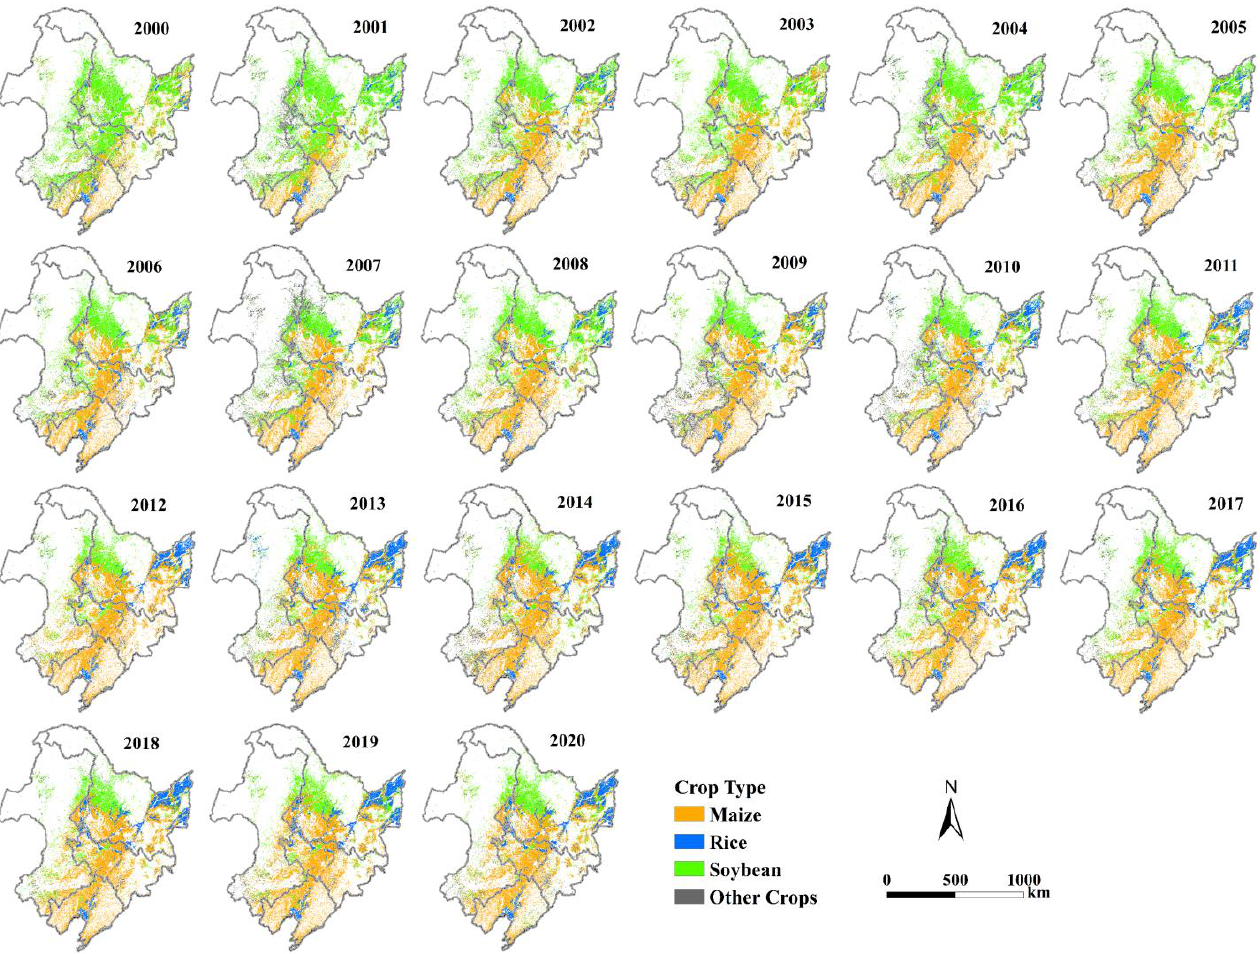
Figure 6. Annual crop type distribution in the NEC from 2000 to 2020.